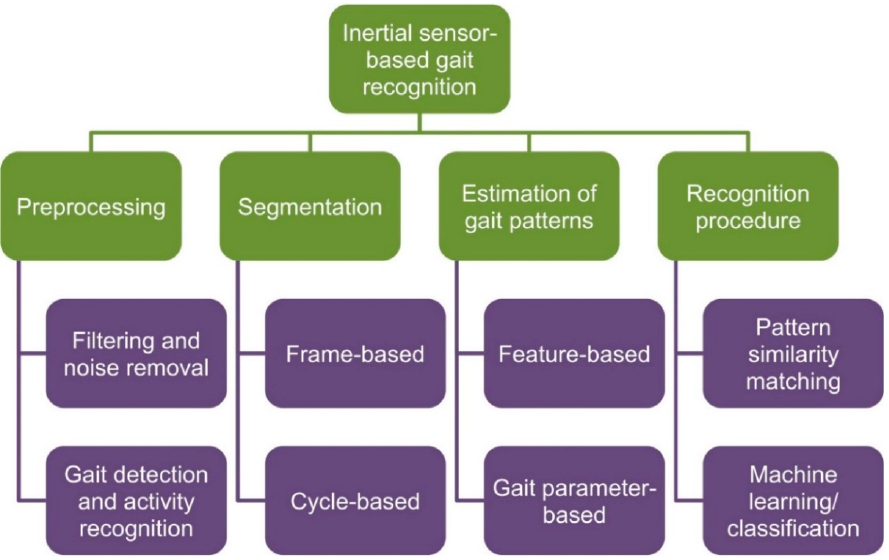
Figure 5. A schematic (hierarchical) representation of a common pipeline for inertial sensor-based gait analysis. Figure modified with permission of the authors of [30].